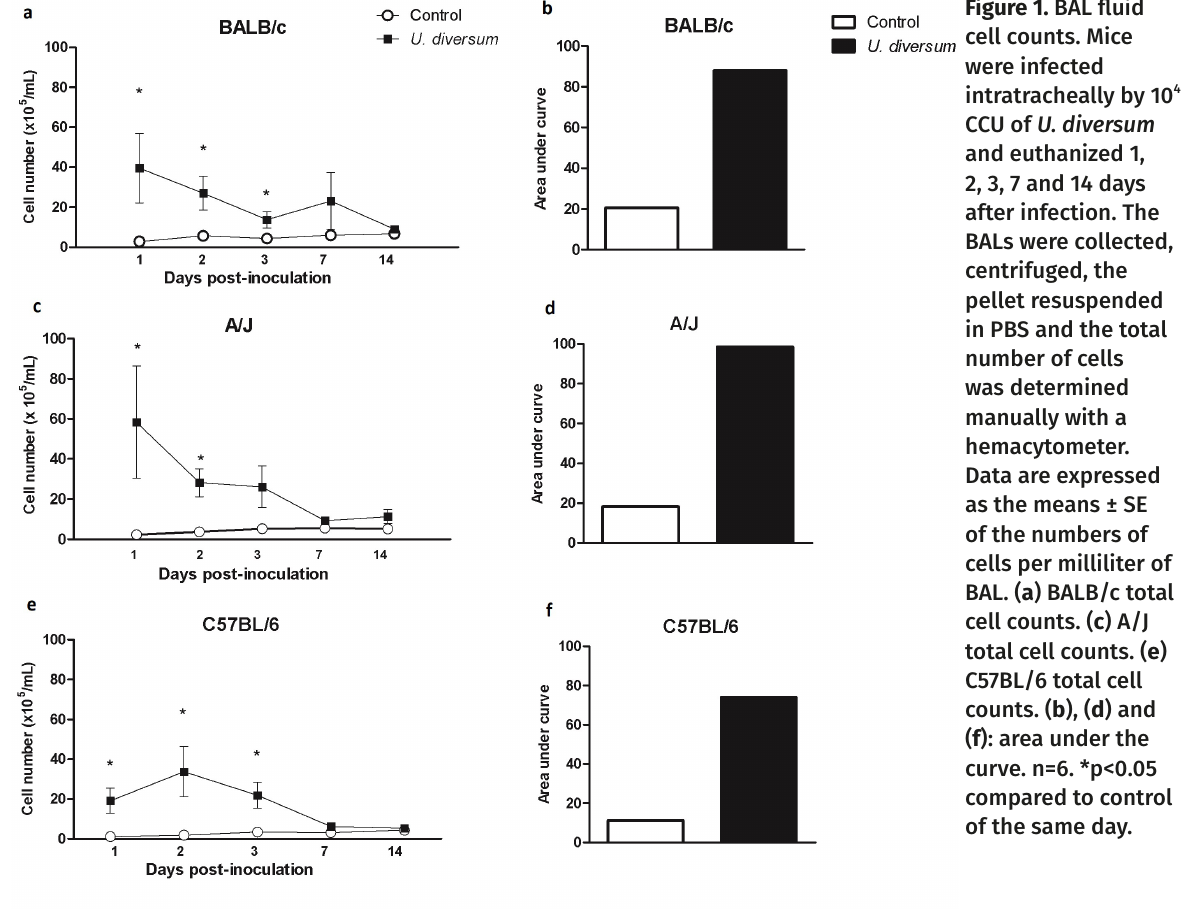
Figure 1. BAL fluid cell counts.